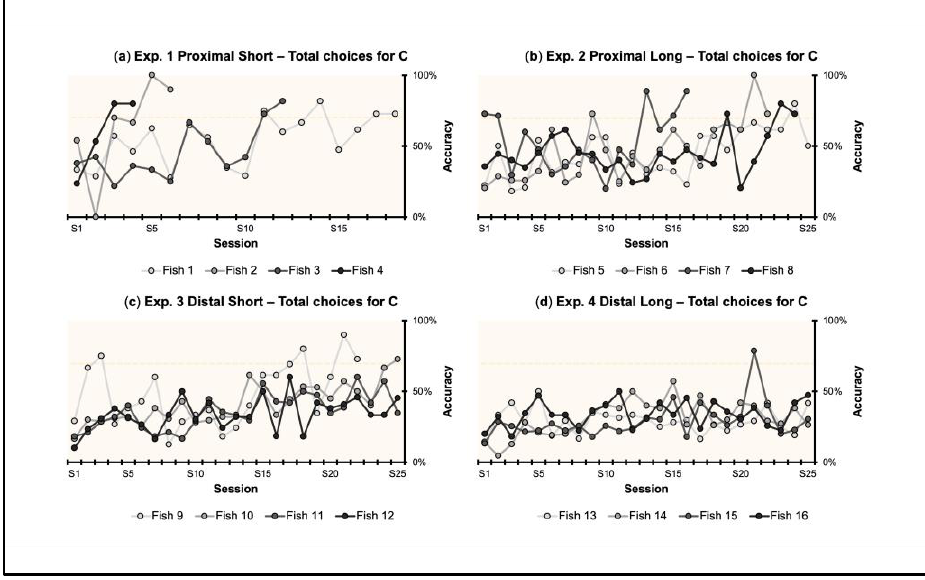
Figure 3. Individual learning curves in the four experimental conditions (PS, PL, DS, DL): total choices. In PS ( a ), 4/4 fish met the 70% accuracy criterion. In PL ( b ), 3/4 fish met the criterion. In DS ( c ), 1/4 fish met the criterion. In DL ( d ), 0/4 met the criterion. The dotted line indicates the 70% threshold.